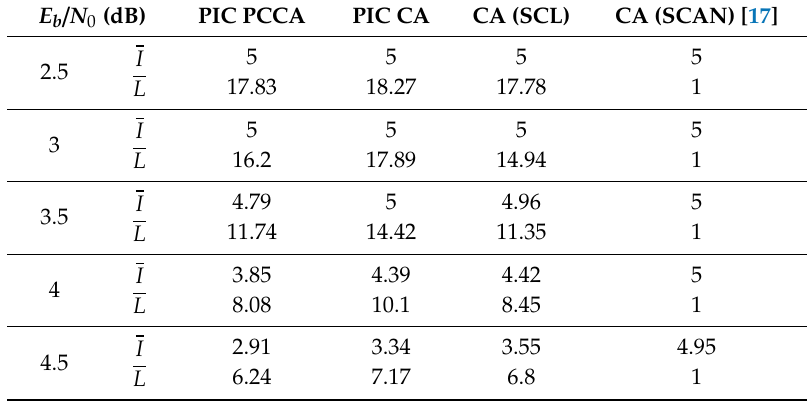
Table 3. The average number of iterations I and the average list size L over AWGN